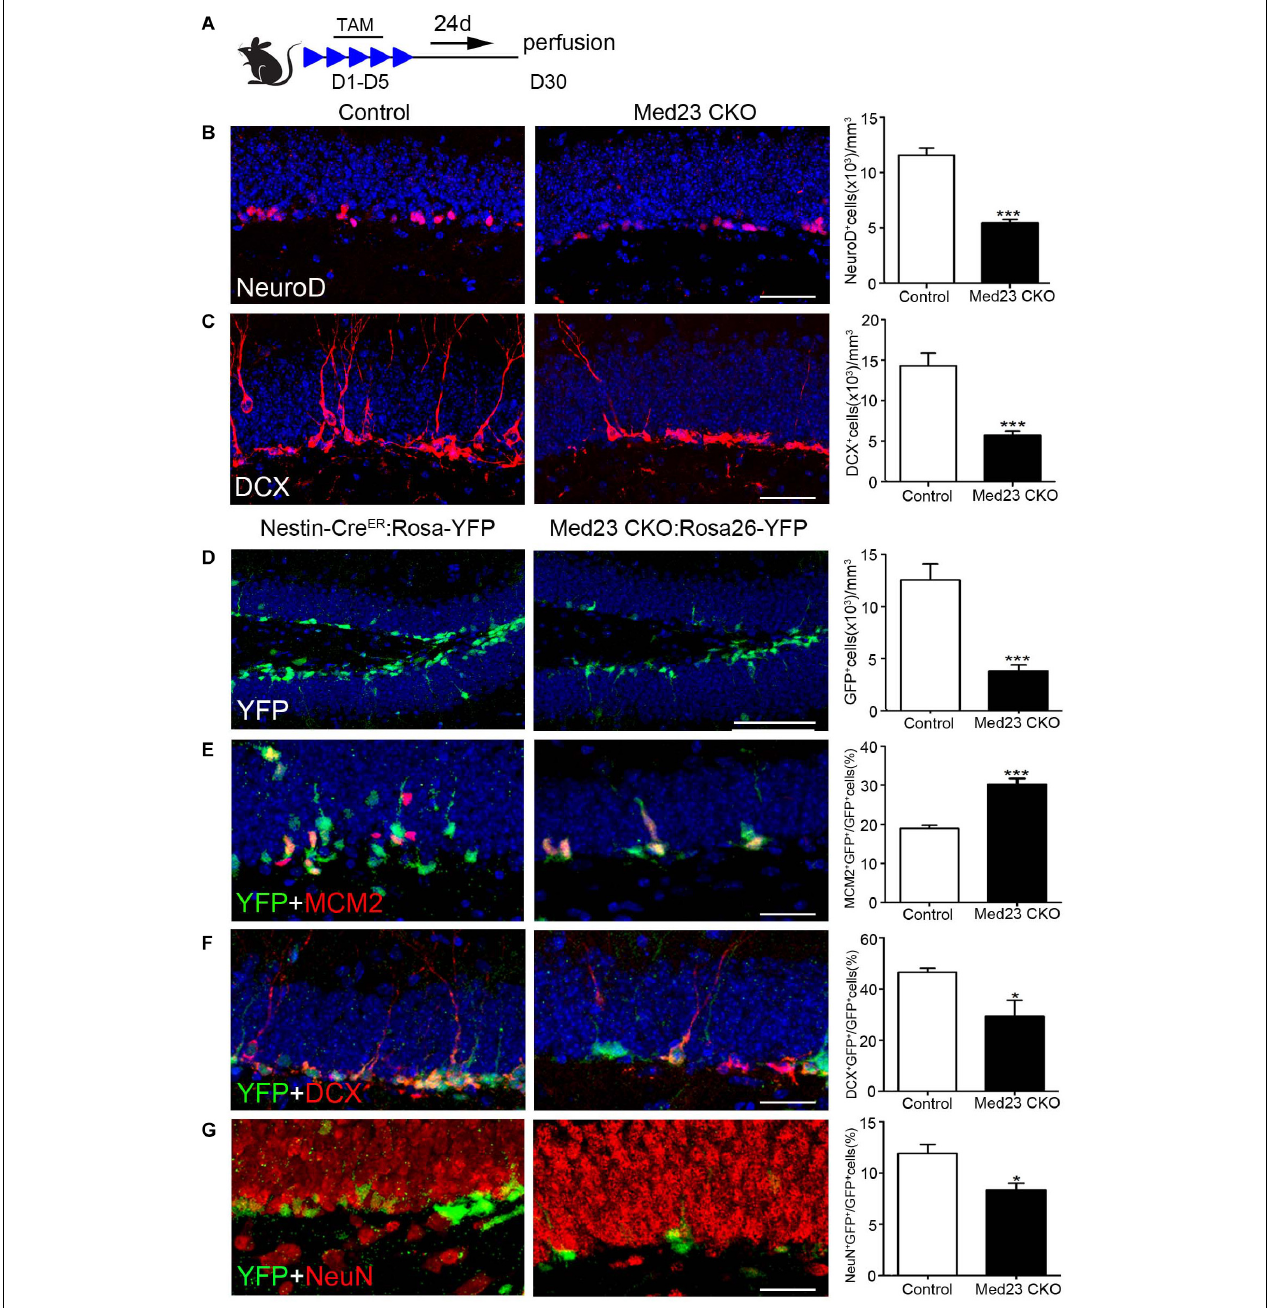
FIGURE 4 | Med23 deficiency results in a reduction of neuroblasts and immature newborn neurons in the SGZ. (A) Schematic representation of TAM treatment. (B,C) Distribution and quantification of NeuroD + and DCX + cells in the SGZ of Med23 CKO mice compared with controls. N = 6 in control and 4 in Med23 CKO groups (B) and n = 5 in each group (C) . (D–G) Distribution and quantification of YFP-expressing cells (green, D ), and its combination with MCM2 (red, E ), DCX (red, F ), and NeuN (red, G ) in the SGZ of Med23 CKO:Rosa26-YFP mice and control Nestin-Cre ER :Rosa26-YFP with Med23 + / + genotype. N = 5 mice in each group (D) ; n = 4 mice in control and 3 mice in Med23 CKO groups (E–G) . Scale bars = 25 µ m. Data are plotted as the mean ± SEM. Student t -test, * p < 0.05, *** p <